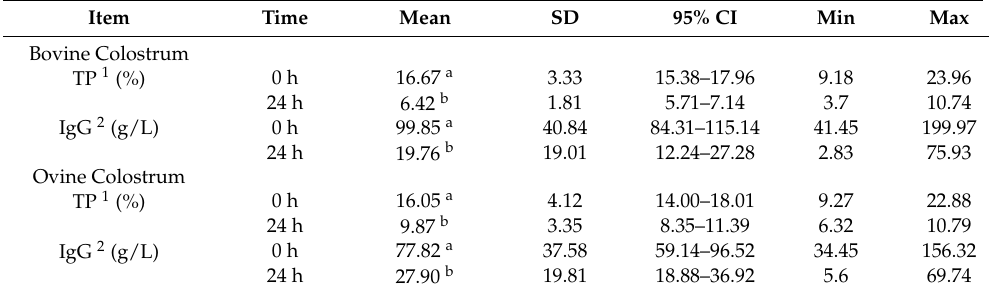
Table 1. Descriptive statistics for colostrum samples analyzed by radial immunodiffusion (RID) and MilkoScan FT +